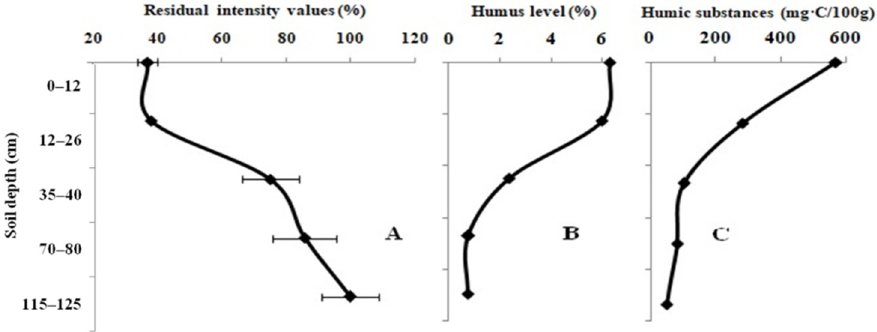
Figure 2. Variation in the residual light intensity of the Red + Luc enzyme system ( A ); humic ( B )